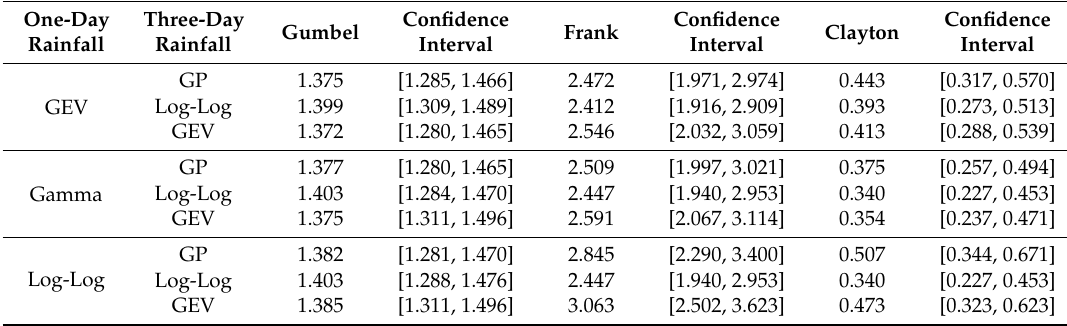
Table 4. Parameters for the copulas and their 95% confidence intervals for one-day and three-day rainfall.